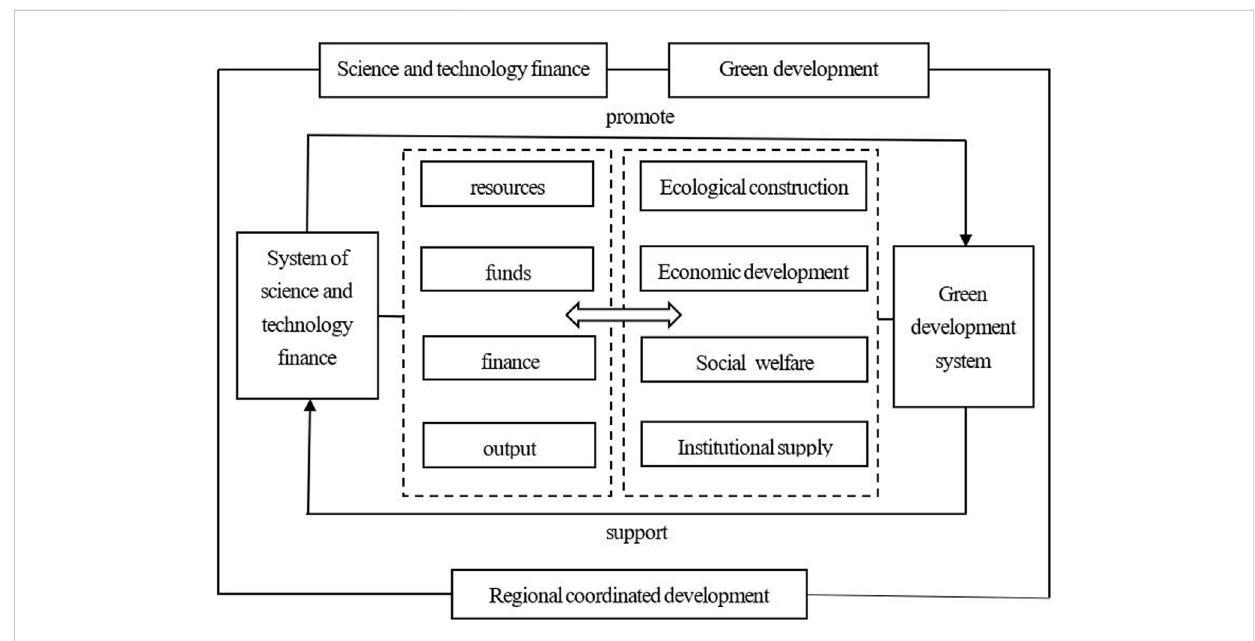
FIGURE 1 Coupling mechanism between science and technology fi nance and green